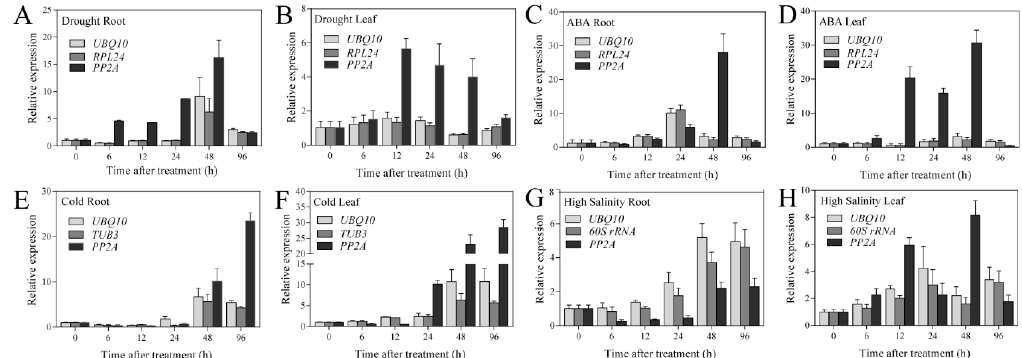
Figure 5. Relative expression levels of PuP5CS2 under different experimental conditions normalized by the top two stable genes and an unstable gene. ( A ),( B ) Drought stress; ( C ),( D ) ABA treatment; ( E ),( F ) cold stress; and ( G ),( H ) high salinity stress.